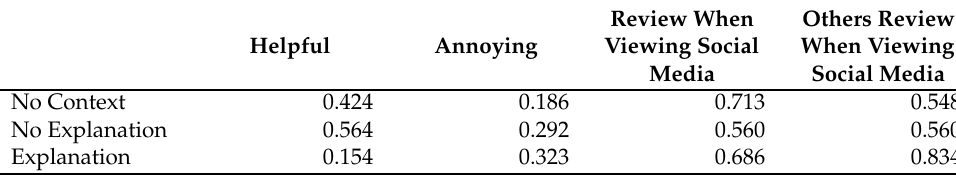
Table A9. Statistical significance calculations for age comparison